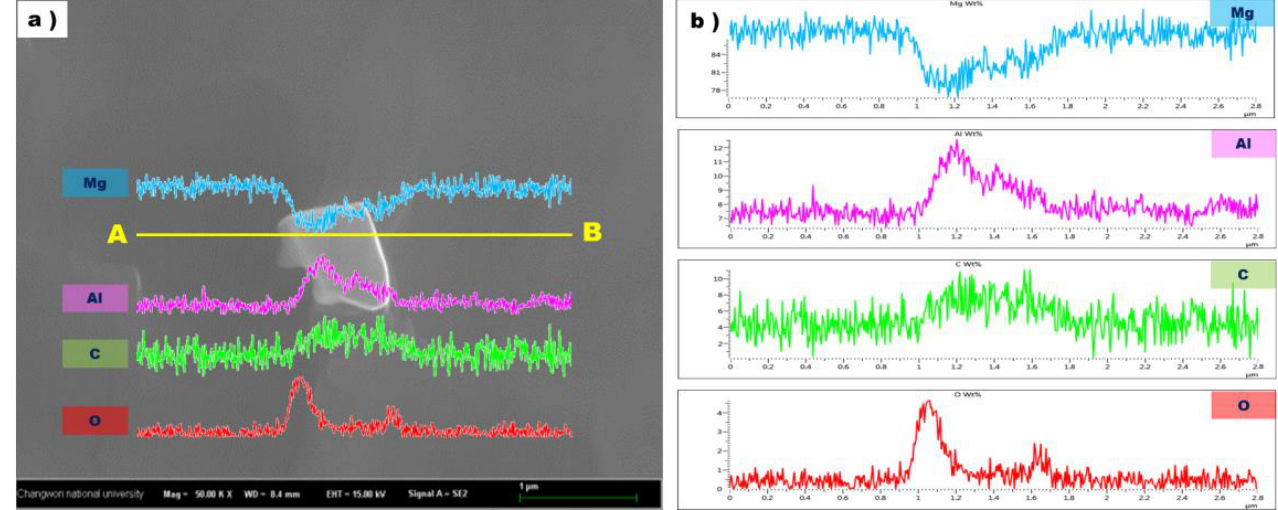
Figure 5. Particle observed in high purity AZ91 ribbon sample ( a ) and the EDS line profile for this particle ( b ).